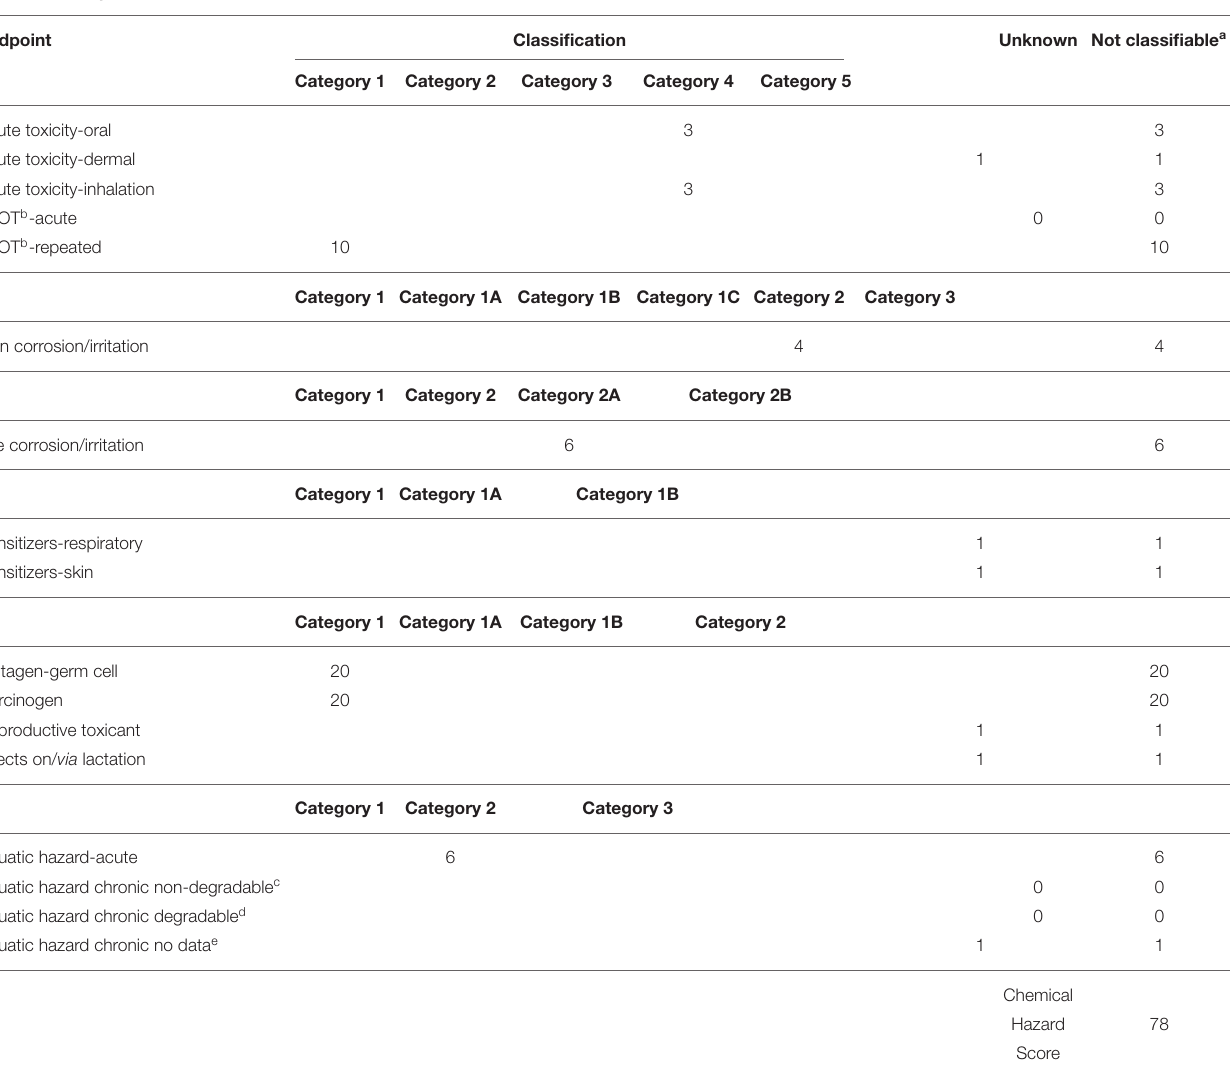
TABLE 2 | Chemical Hazard Score for benzene based on sample SDS (Airgas, 2020) and Table 1 . Benzene